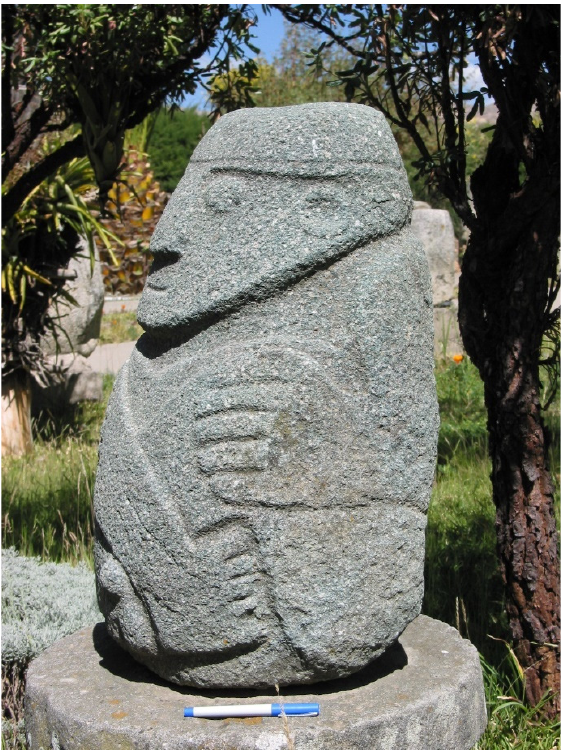
Figure 2. Stone monolith carved in the form of a seated, cross-legged mummy. Note the flat mask-like face, ear spool, and flexed and tucked position. Such effigies may have replaced disintegrated bundles or sought to show the lithification and enduring materiality of ancestors. Museo Arqueológico de Ancash, Huaraz. Photograph by author.